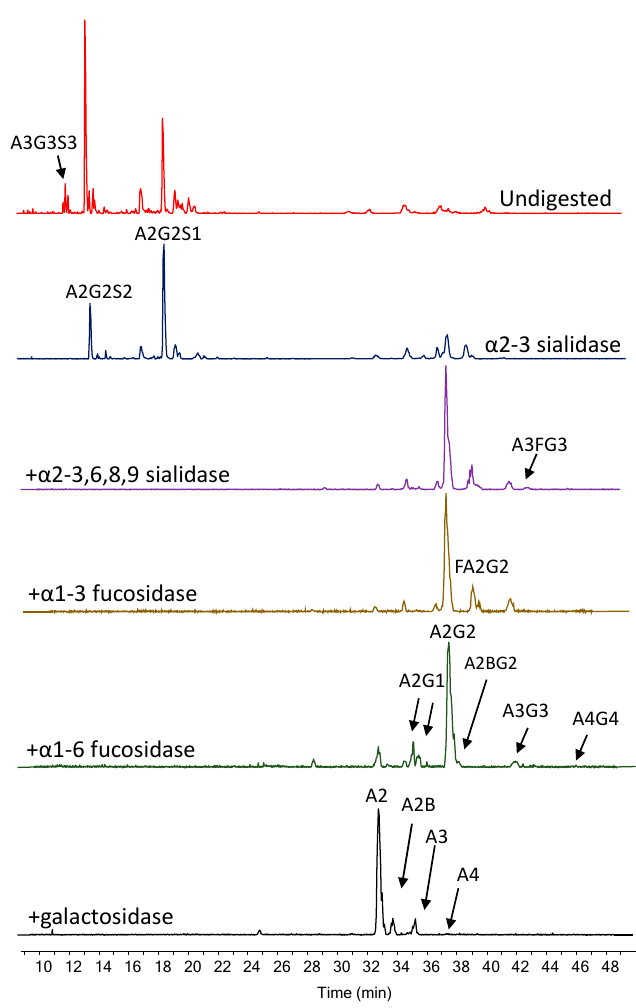
Figure 1. Exoglycosidase sequencing of 2-AA labelled human serum N-glycans by dynamic capillary coating-based capillary electrophoresis mass spectrometry. 120 Table 1. Annotated glycan structures by CE-MS/MS and exoglycosidase sequencing. 121